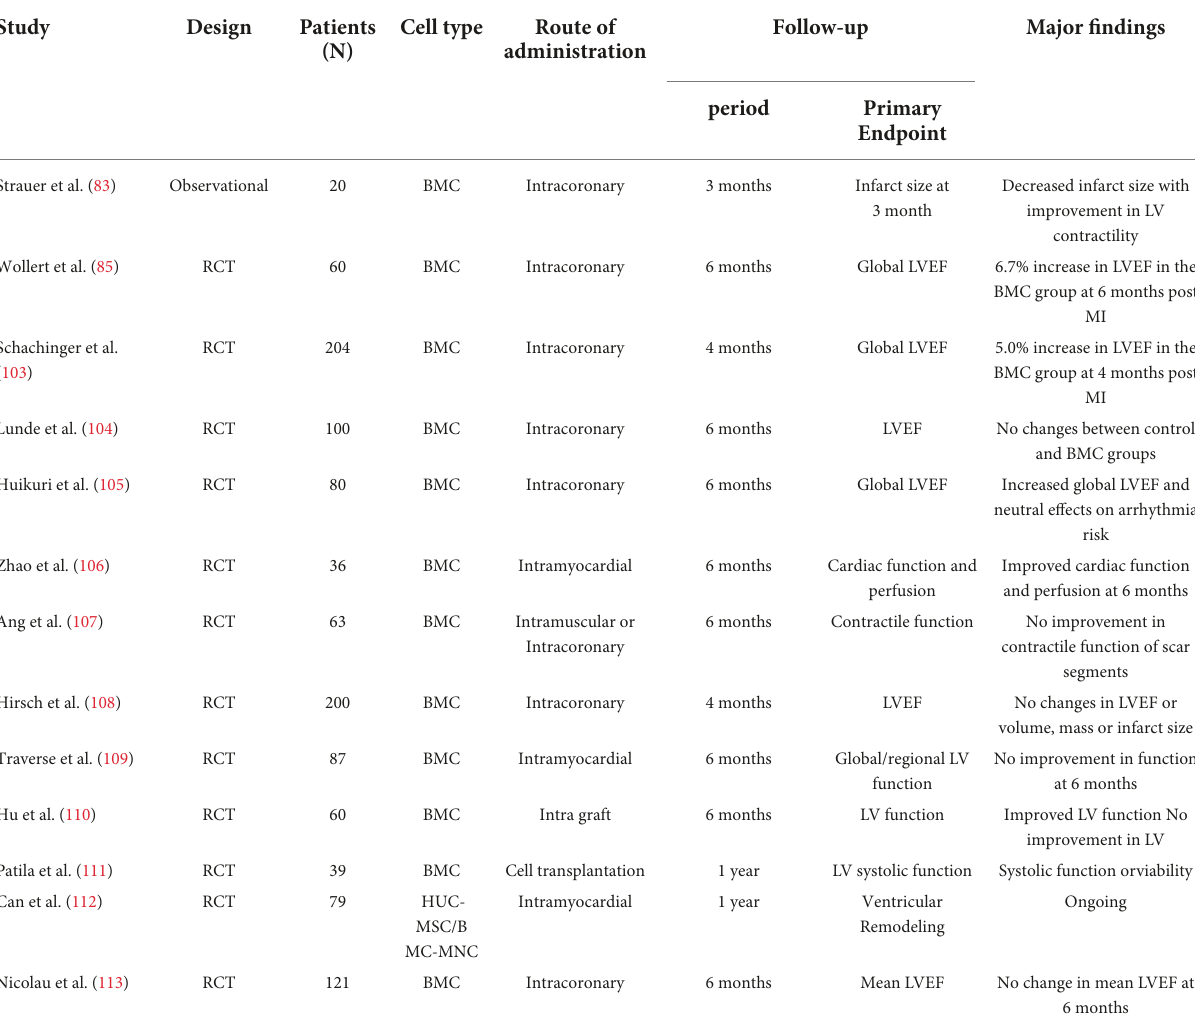
TABLE 3 Stem cell therapy in ischemic cardiomyopathy after